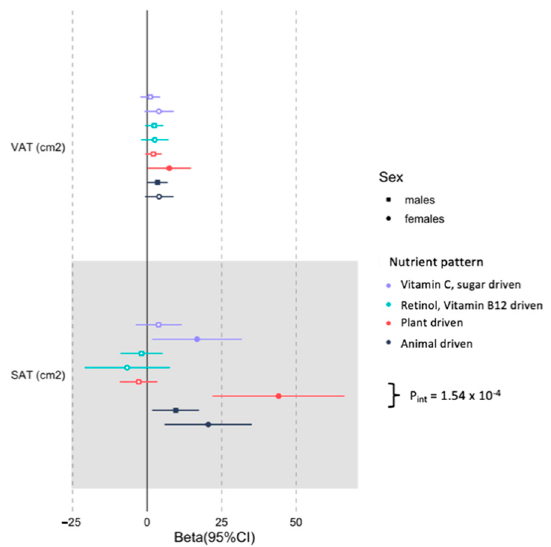
Figure 2. Stratified abdominal subcutaneous adipose tissue (SAT) and visceral adipose tissue (VAT) associations with nutrient patterns in middle-aged black SA men and women. The associations are adjusted for age, number of steps, education status, SES status, energy intake reporting and fat mass index. Non-significant effect sizes are indicated as hollow.